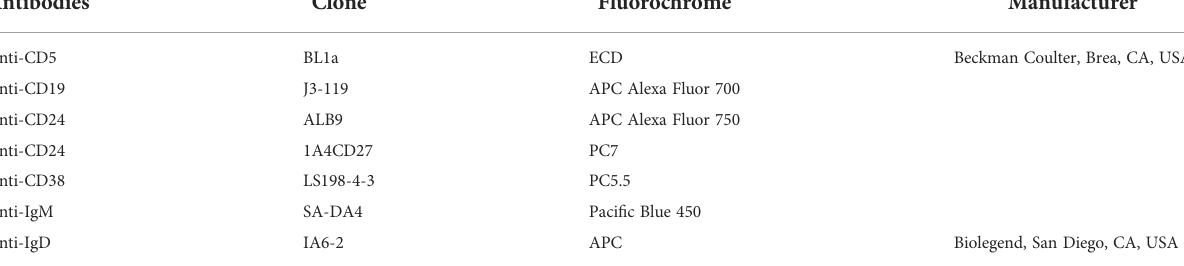
TABLE 3 Antibodies used in the fl ow cytometry analysis.